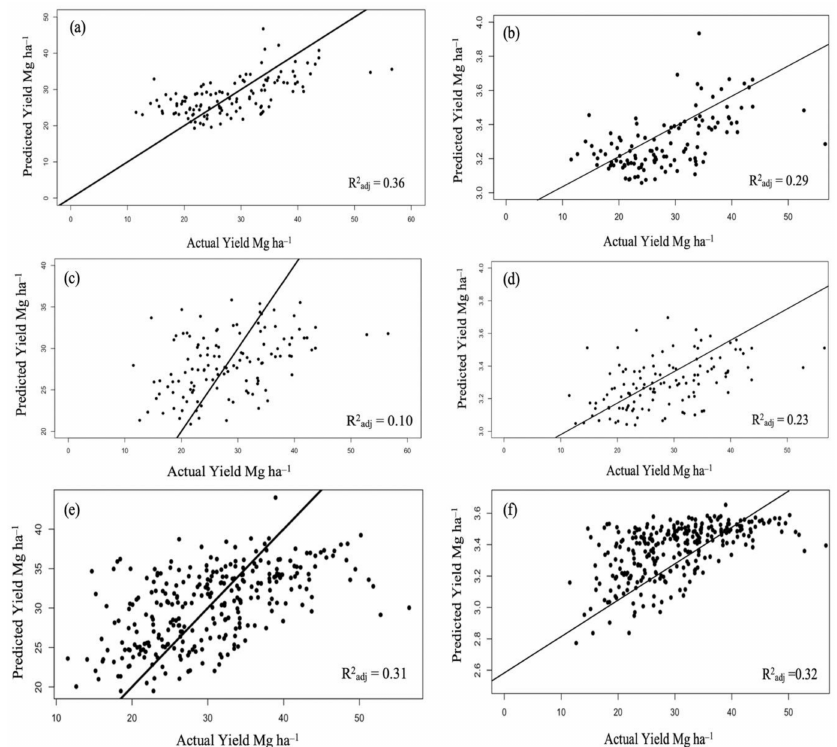
Figure 4. Relationship between the actual and predicted total potato yield for the sensing dates of ( a ) 25 June, theuntransformedmodel; ( b )25June,thetransformedmodel; ( c )22July,theuntransformedmodel; ( d )22July, the transformed model; ( e ) 1 August, the untransformed model; ( f ) 1 August, the transformed model.